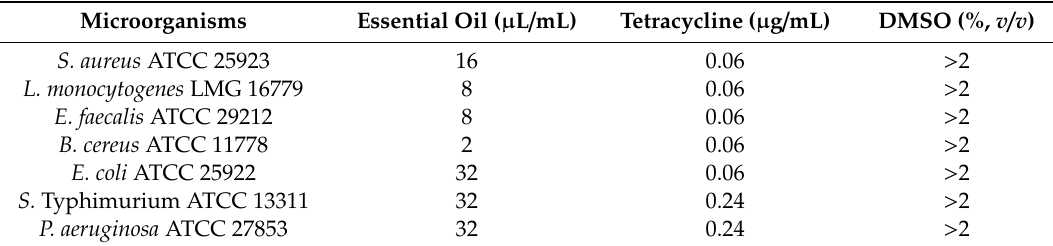
Table 4. MIC values of rockrose